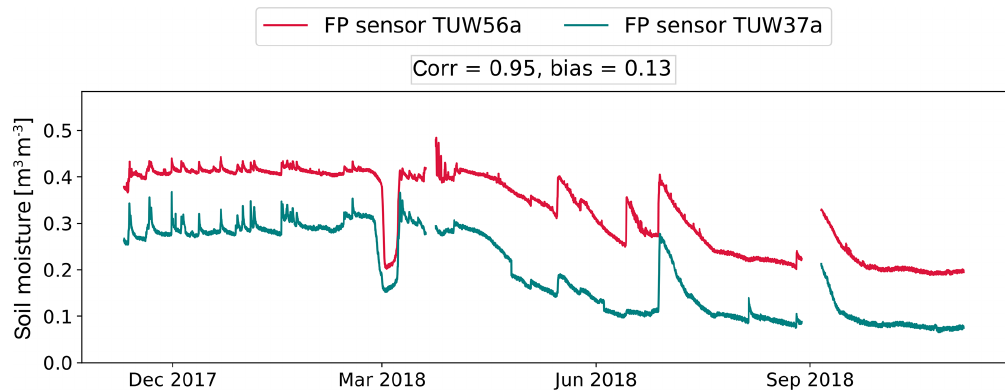
Figure A6. Soil moisture time series of FP sensors number TUW37a and TUW56a, where TUW37a is installed vertically and TUW56a is installed